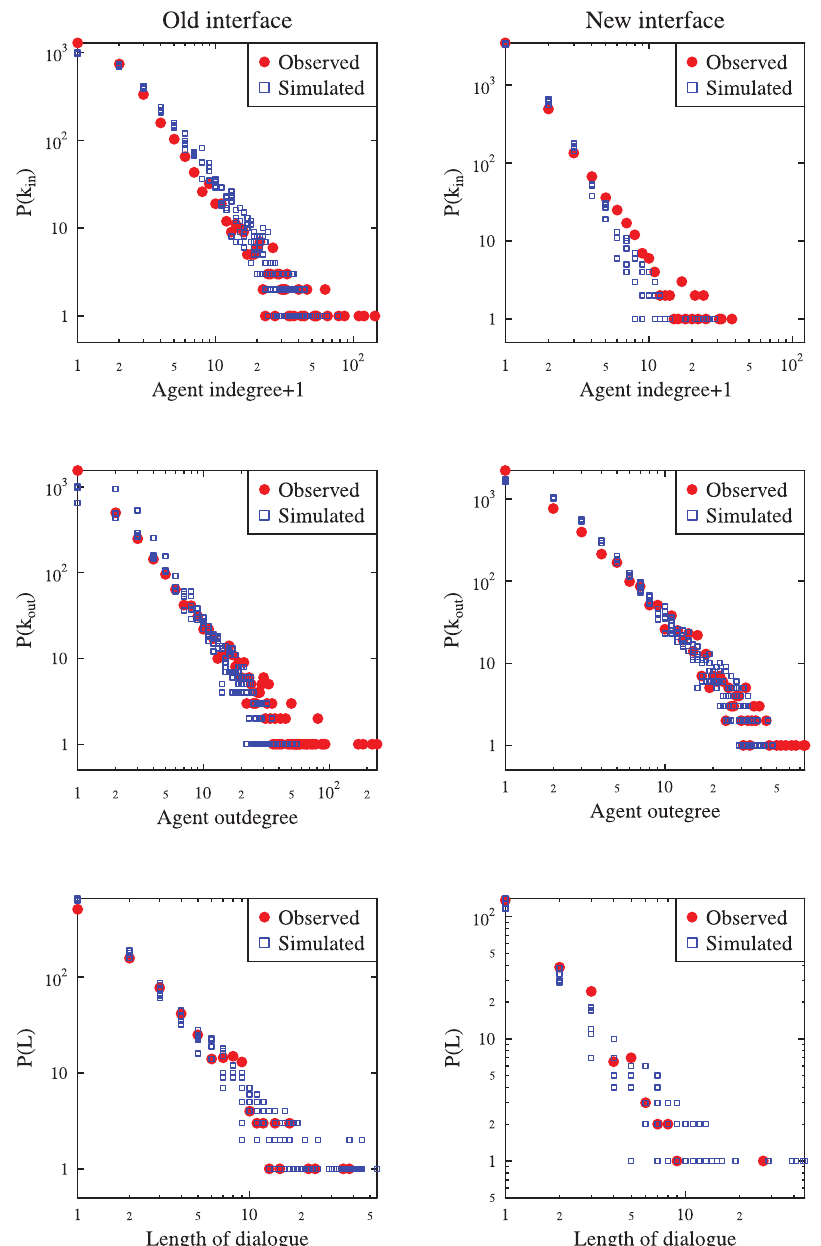
Figure 2. Comparison of basic network characteristics between the observations and simulations for the two discussion fora. The distribution of the agent in-degree, out-degree and the length of dialogs between pairs of users are presented. Blue squares represent results of five independent runs of the network simulation module, red dots are the observed values.